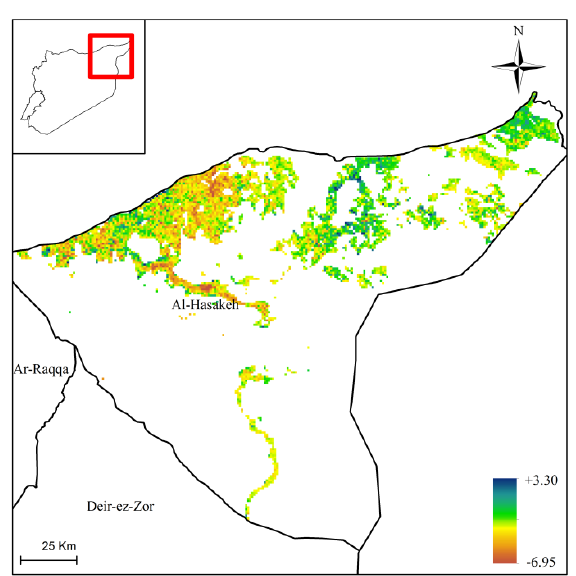
Figure 4- Standardized cumulative summer EVI for 2012 in